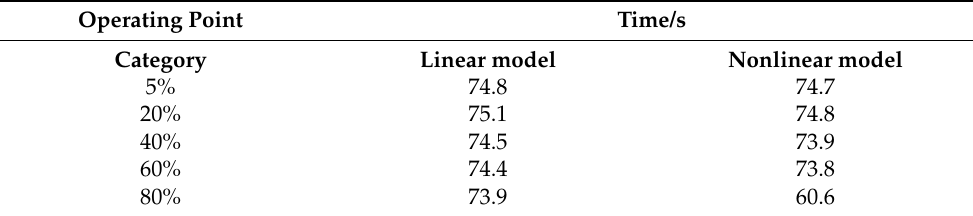
Table 2. Time for the system to reach the equilibrium point in the process of load